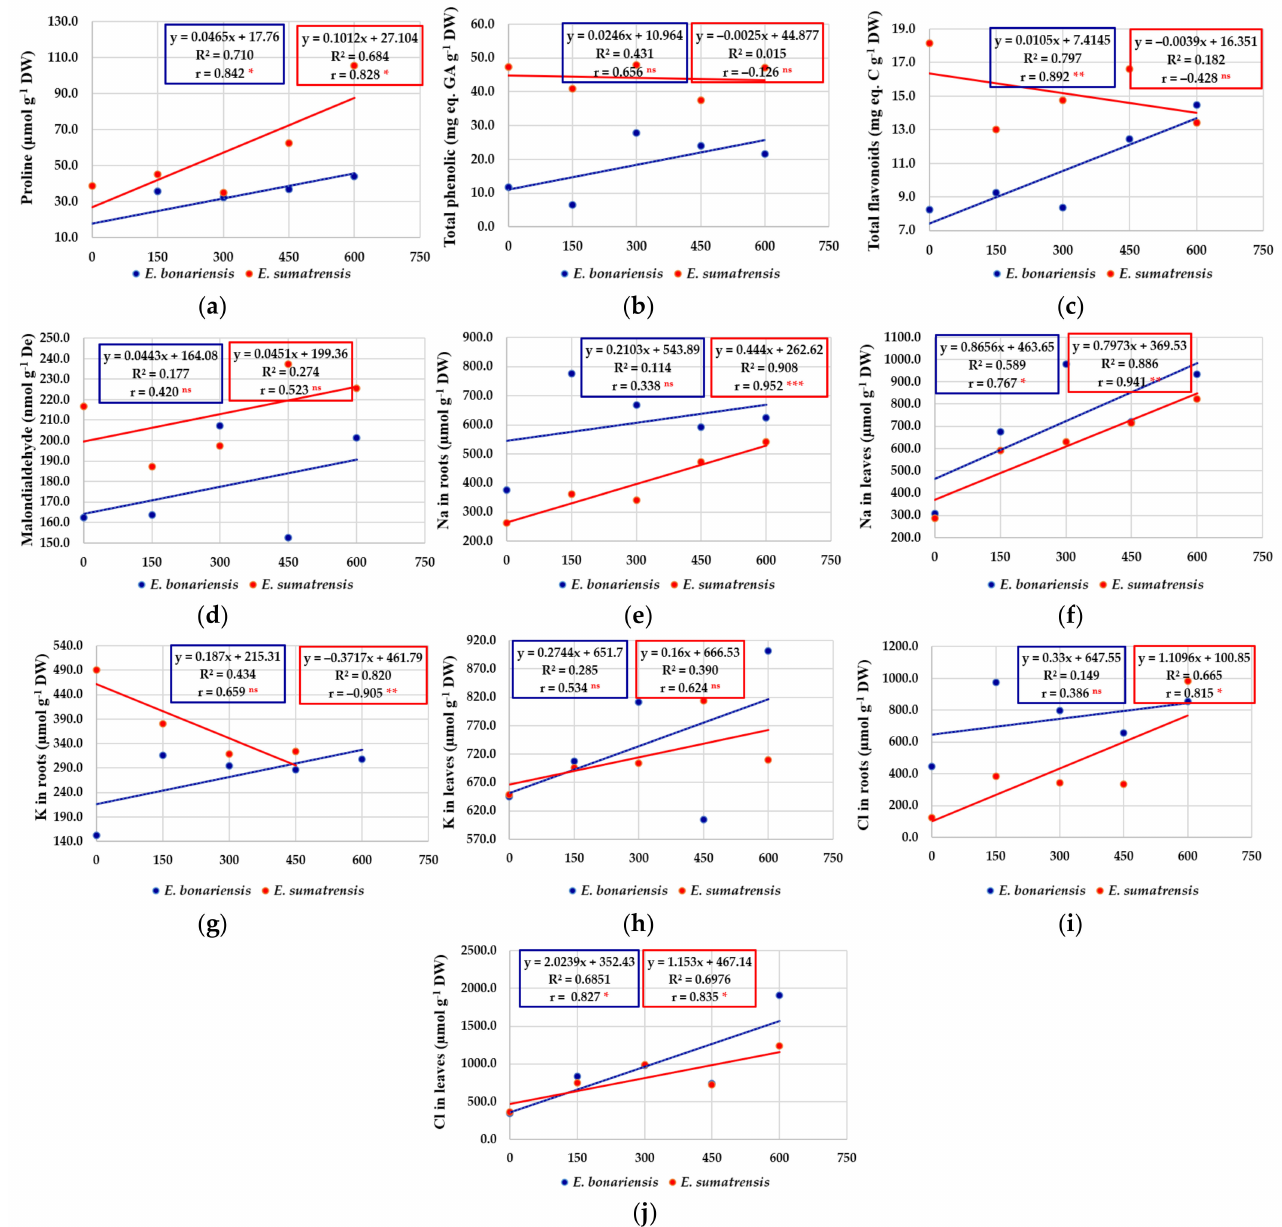
Figure 8. The effect of salt concentration (NaCl solution at 0, 150, 300, 450, and 600 mM) on the concen- trations of proline, total phenolics, and flavonoids and monovalent ions measured in E. bonariensis and E. sumatrensis species: ( a ) Proline; ( b ) Total phenolic compounds; ( c ) Total flavonoids; ( d ) Malondialde- hyde; ( e ) Na in roots; ( f ) Na in leaves; ( g ) K in roots; ( h ) K in leaves; ( i ) Chlorine in roots; ( j ) Chlorine in leaves. In each figure are presented regression equation, the coefficient of determination (R 2 ), and the coefficient of correlation (r). For r, ‘ns’ superscript means not significant, and the asterisks indicate the degree of significance: * <0.05, ** <0.01; ***